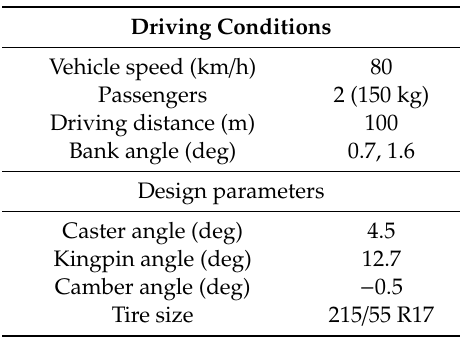
Table 1. The estimation conditions of steering